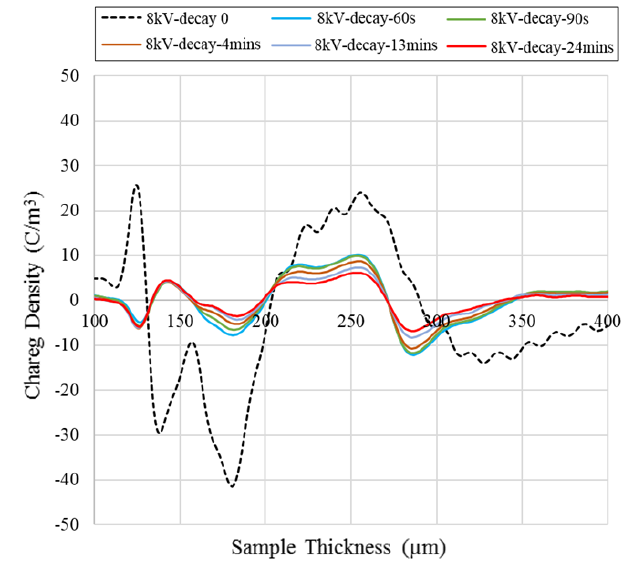
Figure 33. Space charge distribution of PPLP sample under 8 kV applied voltage (volt ‐ off).